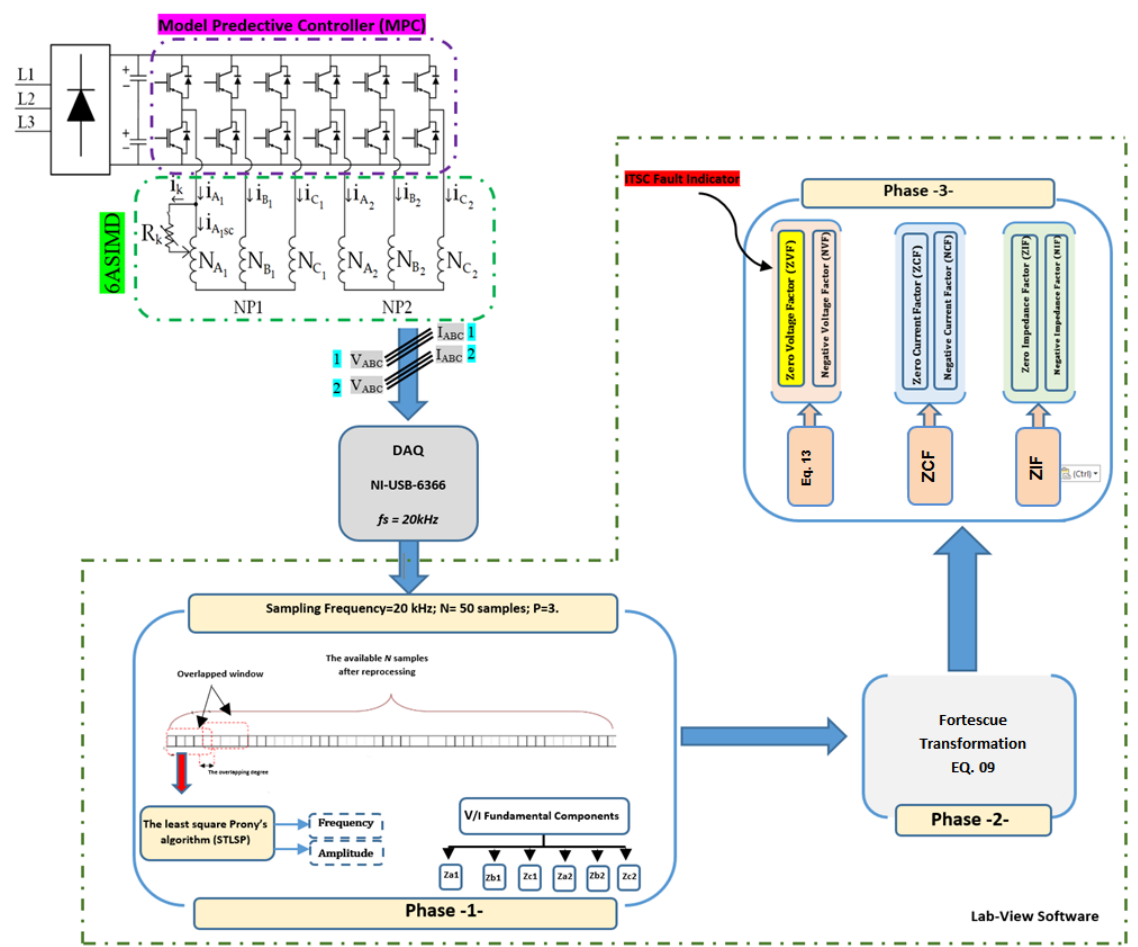
Figure 6. Demonstration of the ITSC fault related to 2NP on the six-phase inverter-fed and ASPIM stator windings.